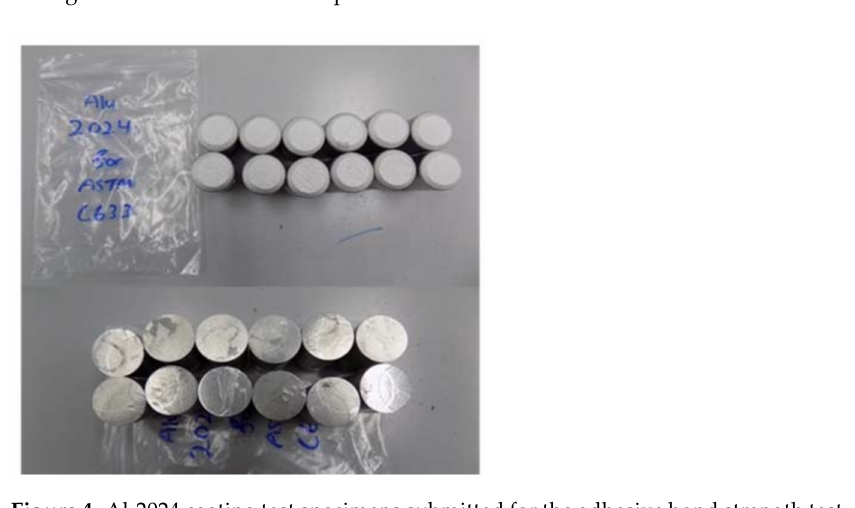
Figure 4. Al-2024 coating test specimens submitted for the adhesive bond strength test. The top image shows the coating top surface, while the bottom image shows the uncoated studs on the bottom